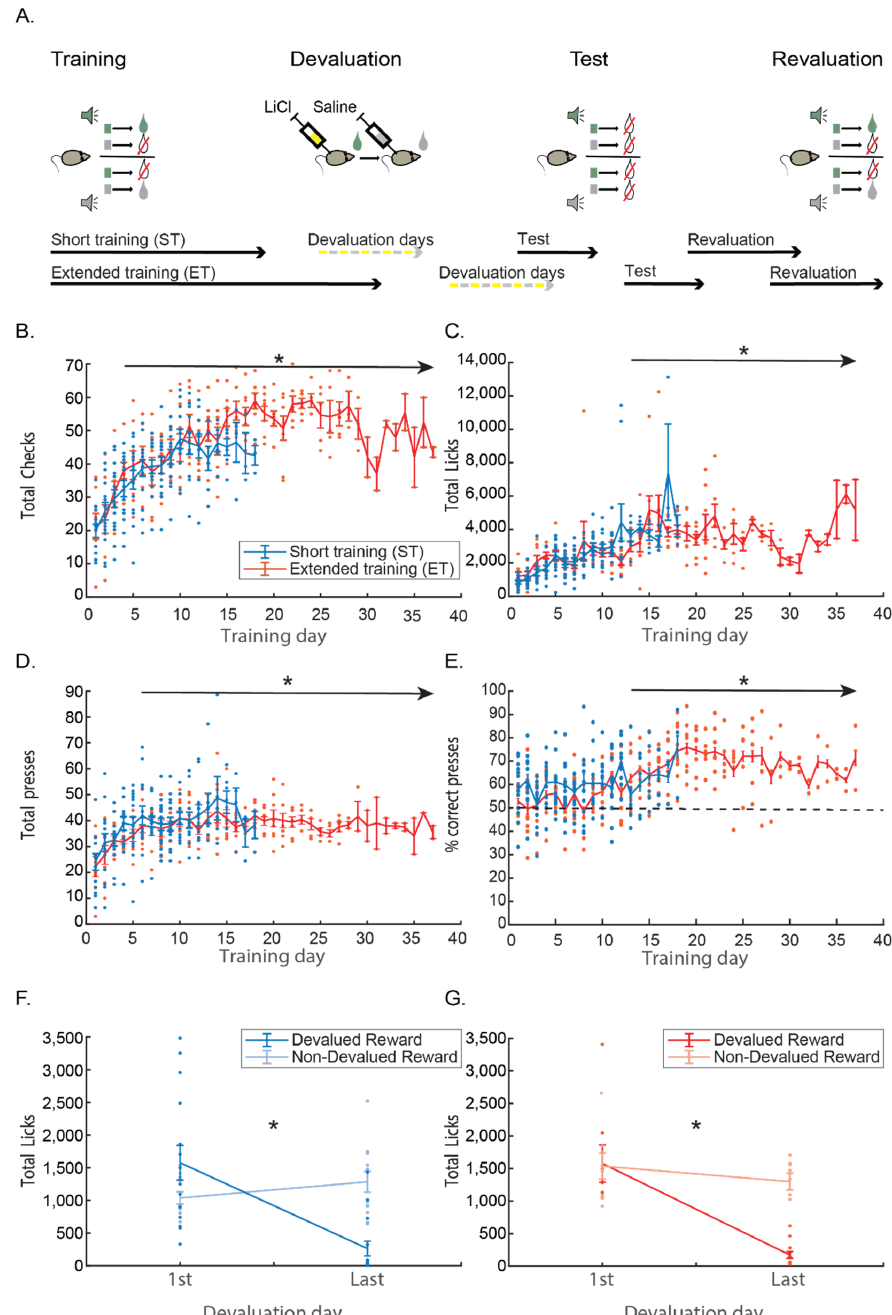
Figure 1. The effects of training on distinctive task behaviors and the following effects of devaluation training. ( A ) Schematic representation of experimental design. In all following figure blue represents the short training group (ST) and red represents the extended training group (ET). Asterisk represents significance of p < 0.05 ( B – E ) Line plots with error bars (standard error) overlaid with the dots of raw data of each mouse describing the change in total magazine checks ( B ), total licks ( C ), total lever presses ( D ), and total correct lever presses over the course of the task’s training days. ( F – G ) Line plots with error bars (standard error) overlaid with the dots of raw data of each mouse describing the change in consumption from the first to the last day of reward devaluation (devaluation included altering days of devalued +LiCl injections and non-devalued rewards + saline injections until reaching learning criterion) for the ST group ( F ) and for the ET group ( G ) both for the devalued reward (darker color) and the non-devalued reward (lighter